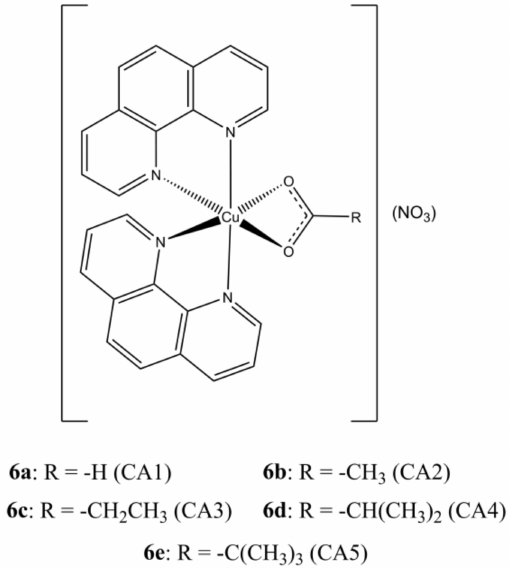
Figure 6. Structures of the [Cu(phen) 2 (CAn)](NO 3 ) 2